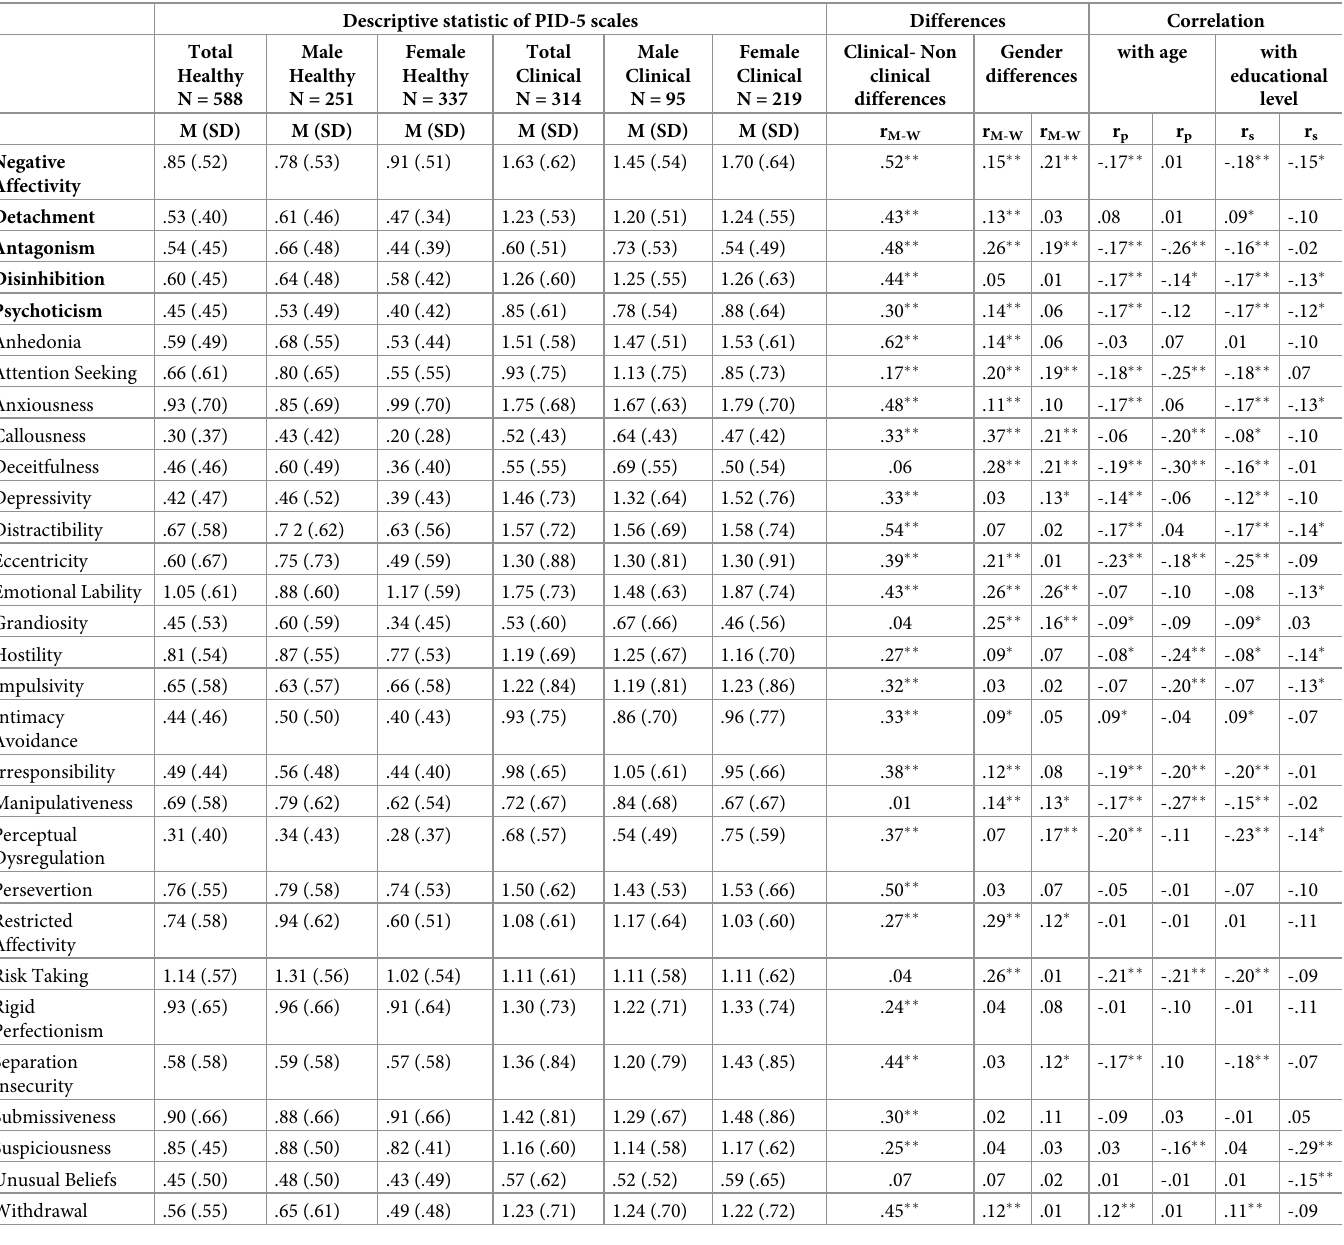
Table 8. Descriptives of PID-5, differences between clinical and non-clinical samples, gender differences, correlation with age and educational